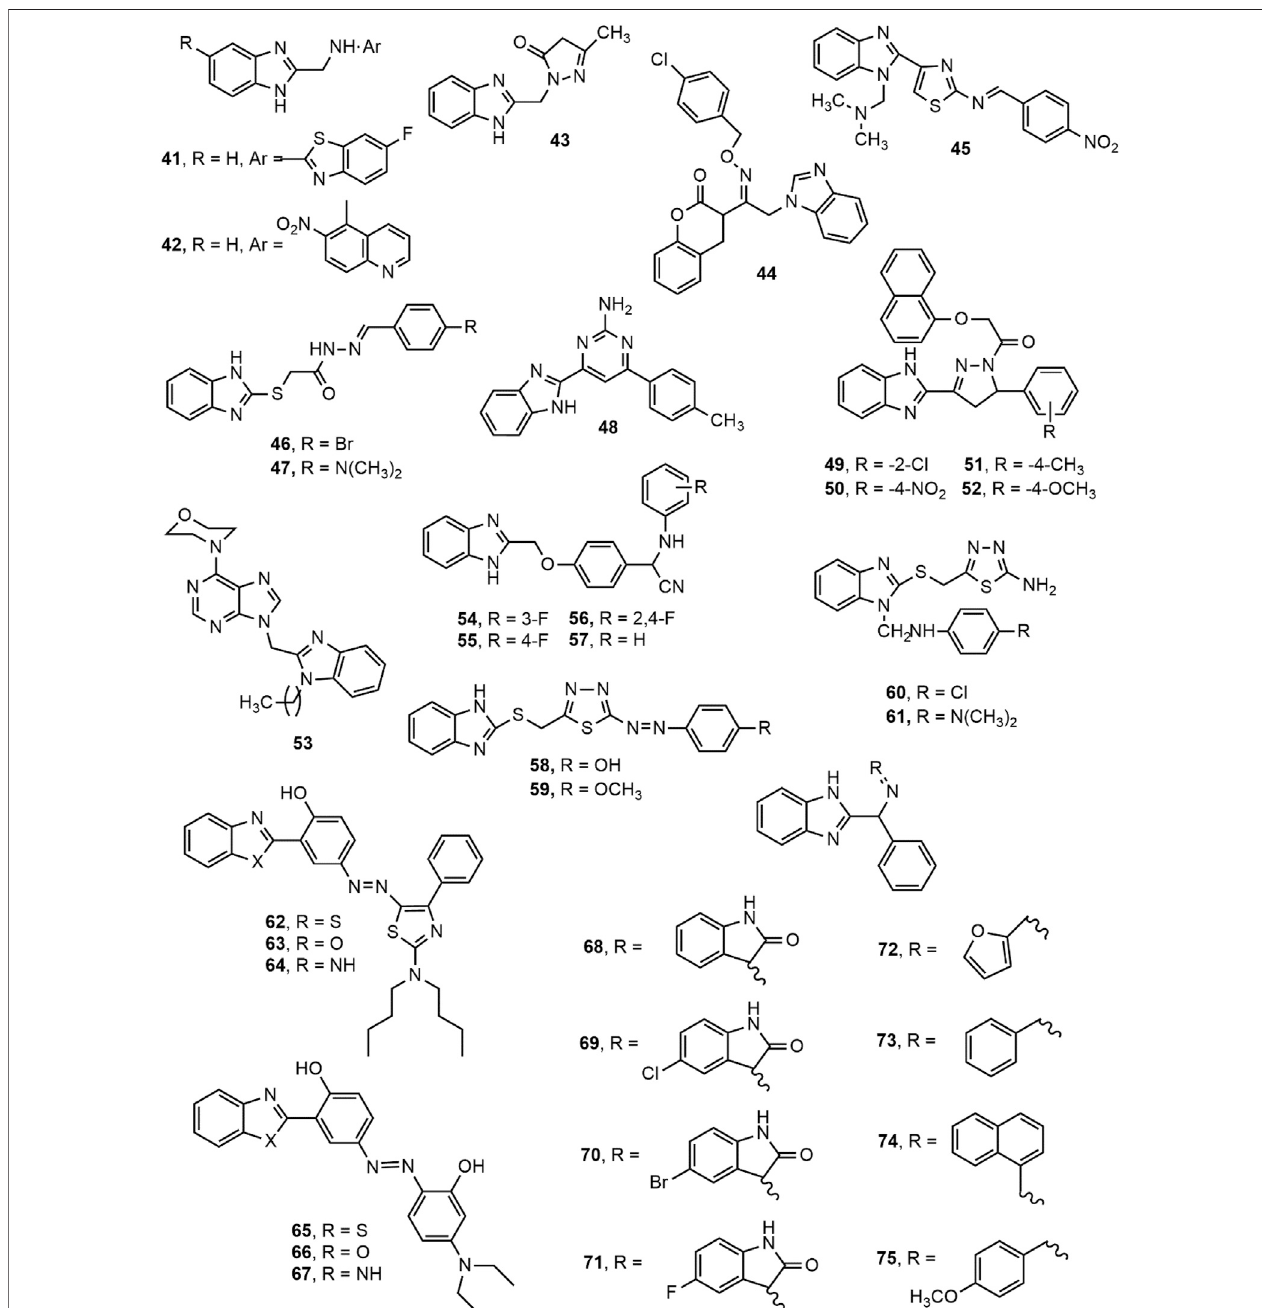
FIGURE 3 | Benzimidazole derivatives with antimicrobial